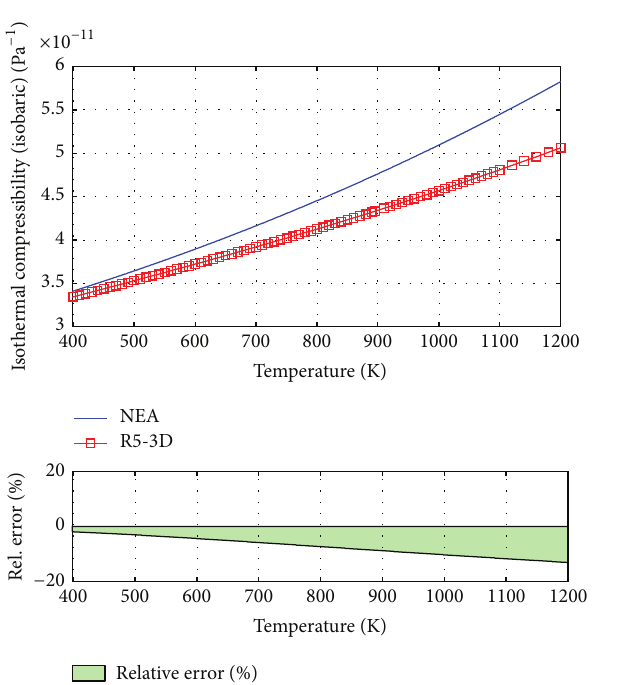
Figure 4: LBE liquid isothermal compressibility original R5-3D “tpf” file versus NEA report.